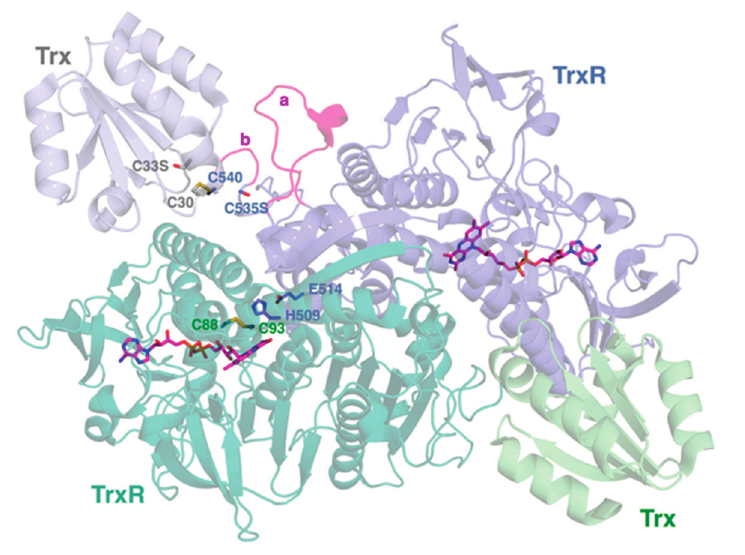
Figure 1. The dimeric structure of P. falciparum thioredoxin reductase (TrxR).